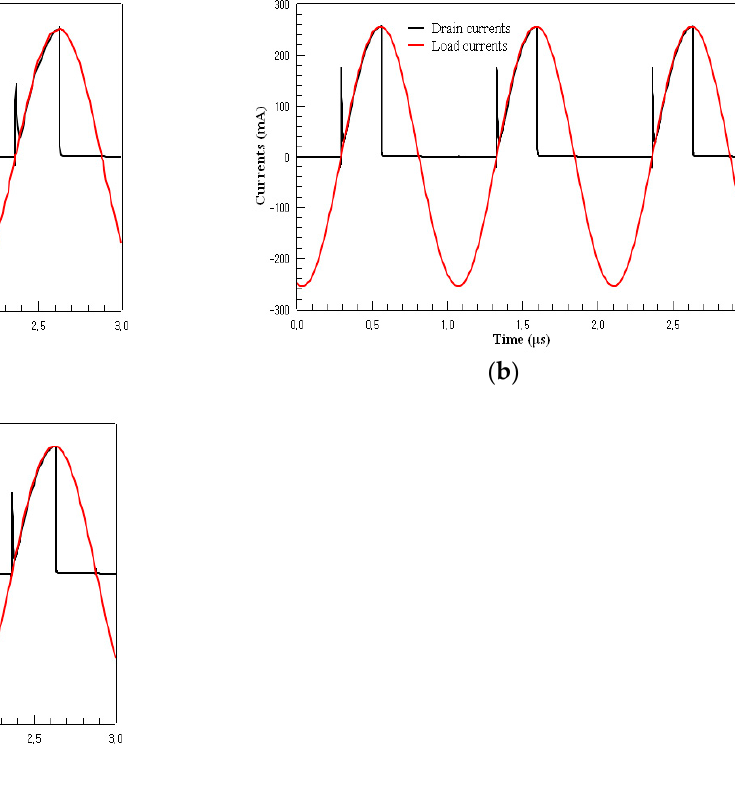
Table 1. Summary of overall power loss and power efficiency with different gate oxide technologies. Gate Oxide